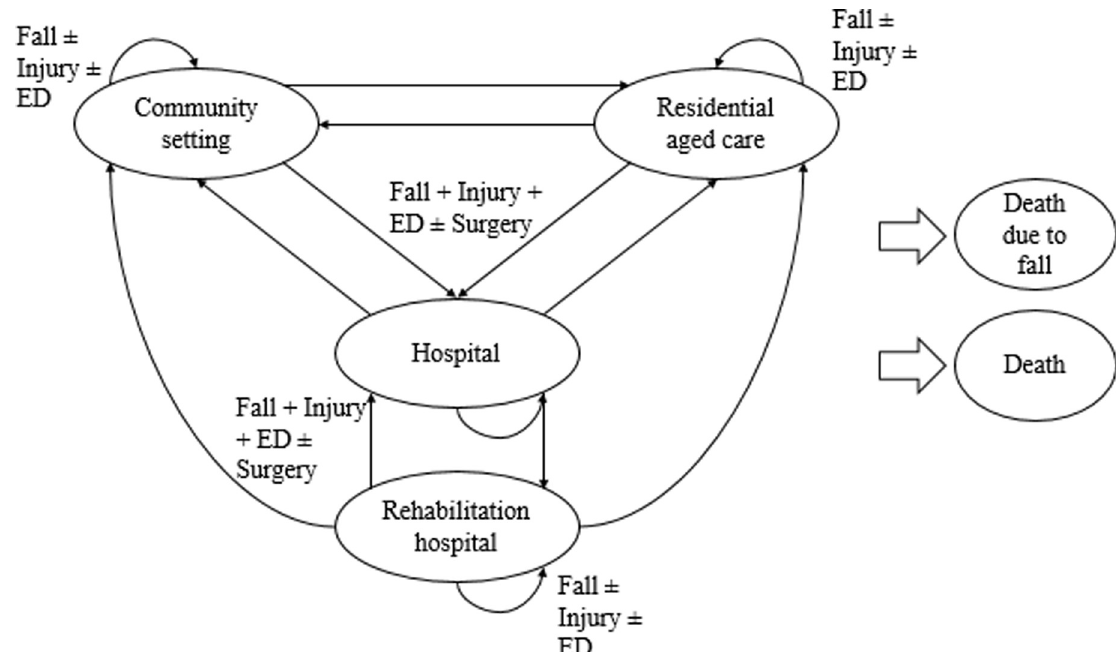
Fig 1. Model structure. Community setting: includes people who are living in settings such as their own home, retirement home, supportive housing or assisted living; Residential aged care setting: includes people living in settings such as long-term care facilities, nursing homes or residential care; Hospital: includes hospital inpatient Rehabilitation hospital: includes rehabilitation hospital inpatients; Death due to a fall: represents those who died as a result of a fall; Death: represents those who died by any cause other than a fall; ED: emergency department visit; Injury: includes hip fracture, vertebral fracture, wrist fracture, and head injury; Surgery: hip fracture surgery.